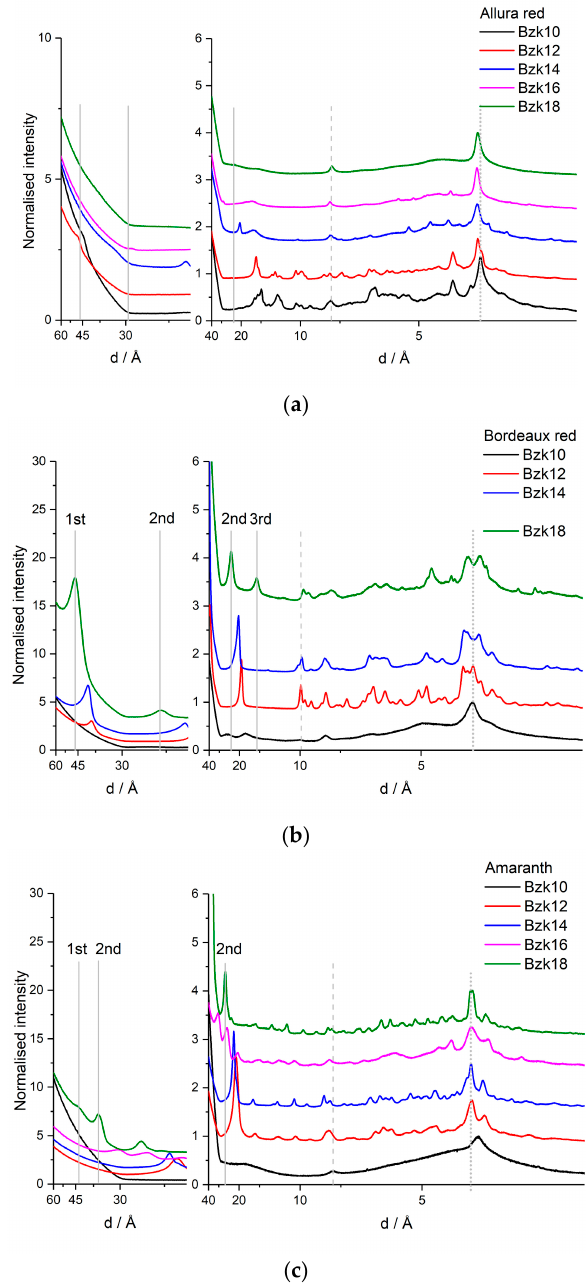
Figure 3. Powder XRD scattering curves for the three series of homolog ionic self-assembled materials based on: Allura Red ( a ); Bordeaux red ( b ); and Amaranth ( c ) anionic azo-dye functional units and benzalkonium surfactants with alkane tails of varying length from BZK10 –(CH 2 ) 9 CH 3 to BZK18 –(CH 2 ) 17 CH 3 . The assumed principal axes are indicated with lines.